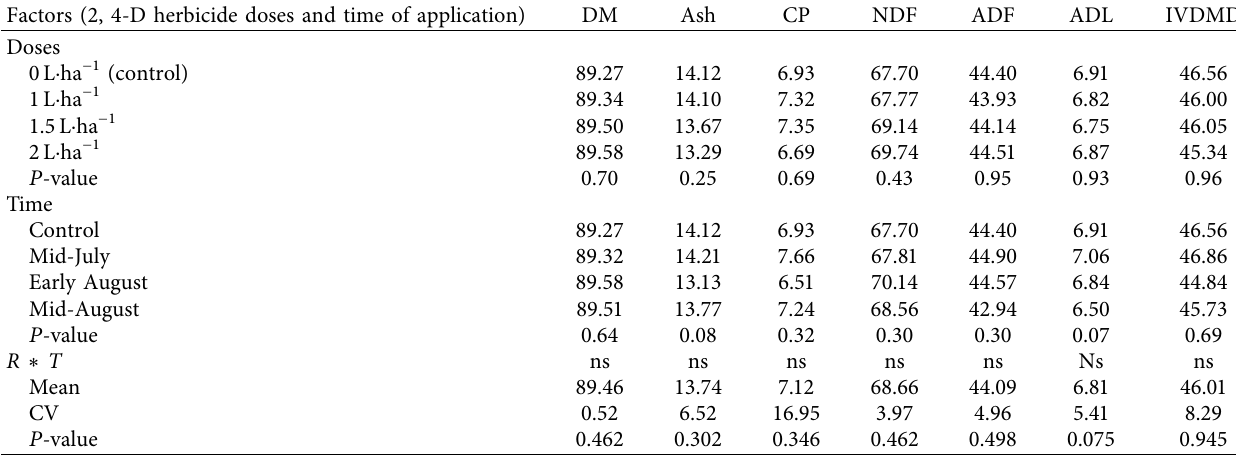
Table 13: Effect of doses, time, and their interaction of 2, 4-D application on the nutritional quality of natural pasture. Factors (2, 4-D herbicide doses and time of application) DM Ash CP NDF ADF ADL IVDMD Doses 0L · ha − 1 (control) 1L · ha − 1 2L · ha −